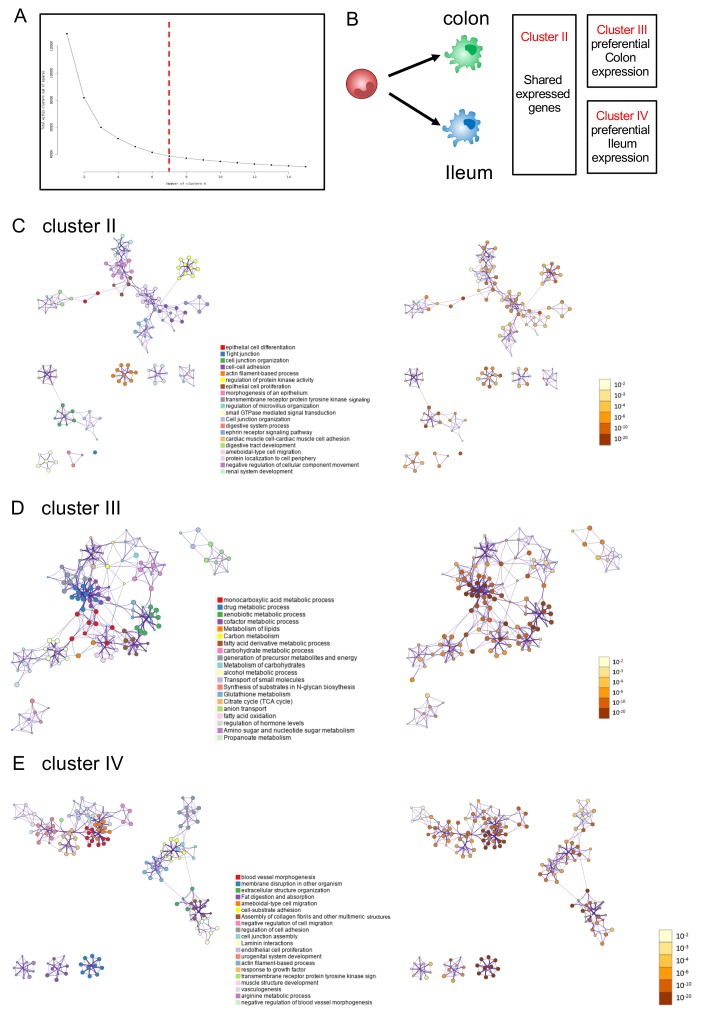
Pathway analysis of graft-derived cells.(A) Elbow plot to determine number of clusters. Since the plot was continuous, visual inspection was performed with different cluster numbers; according to cluster homogeneity we selected k = 7. (B) Schematic of clusters related to Figure 1D. (C) Metascape pathway analysis cluster II, genes shared by colonic and ileal monocyte graft-derived macrophages. (D) Metascape pathway analysis of cluster III, genes preferentially expressed by colonic monocyte graft-derived macrophages. (E) Metascape pathway analysis of cluster IV, genes preferentially expressed by ileal monocyte graft-derived macrophages.